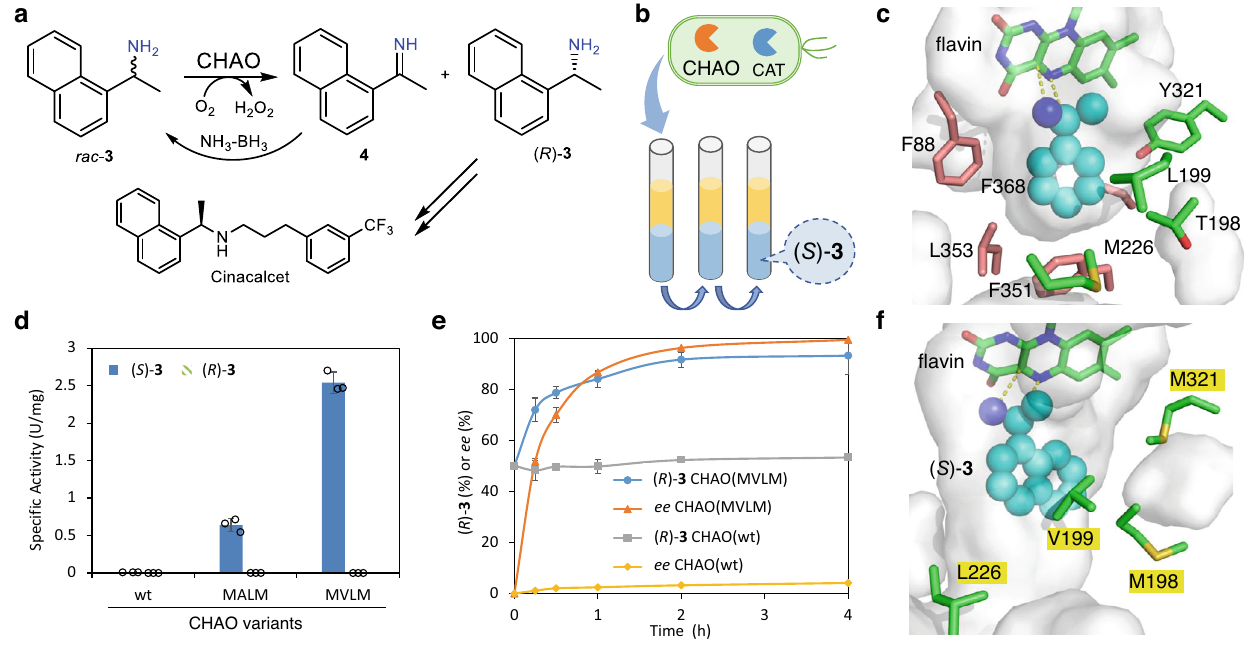
Fig. 4 | Growth-based directed evolution of CHAO for the deracemization to produce ( R )-3. a Targeted reaction for the deracemization of rac - 3 to ( R )- 3 . b The principle of the growth selection is based on E. coli cells co-expressing CHAO variantsandacatalase(CAT)inthetwo-phasesystem(methyllaurateandM9liquid medium) where amine ( S )- 3 (1mM in the aqueous phase) serves as the only nitro- gensource. This ensuresa non-toxic concentrationbut suf fi cient supplyof( S )- 3 to the cells and simultaneous removal of the toxic ketone product. c Identi fi cation of twogroupsofhotspotsbydockingof( S )-1-phenylethylamine(truncatedsubstrate,